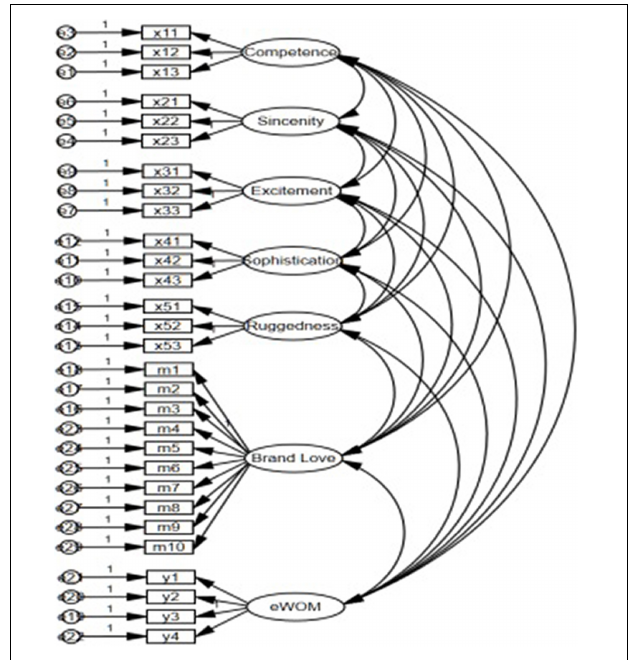
FIGURE 2 | Measurement model.